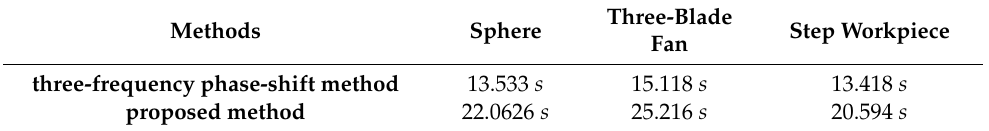
Table 1. The average running time of proposed method and three-frequency phase-shift